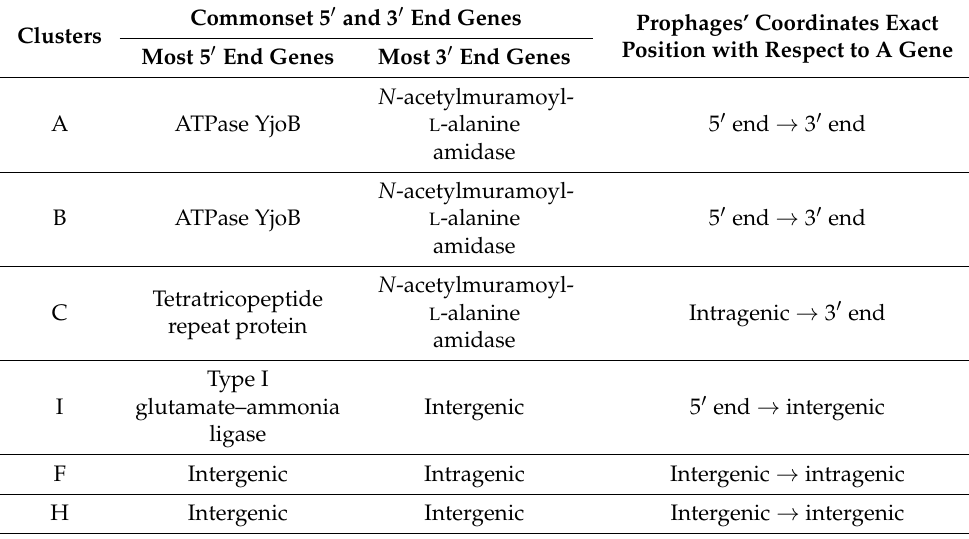
Table 2. Genes present at 5 (cid:48) and 3 (cid:48) integrated intact prophage ends.